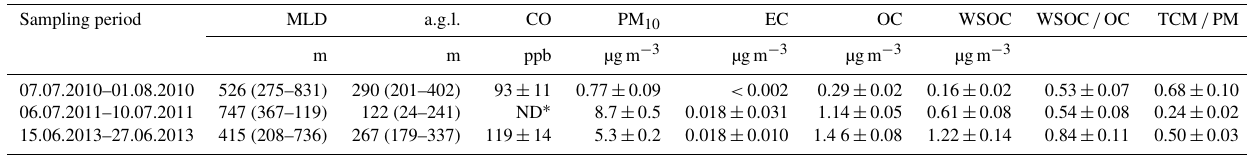
Table 5. Average CO, PM 10 , and carbonaceous species concentrations ( ± SD) together with WSOC / OC and TCM / PM ratios obtained during the cleanest periods in the growing season. MLD and ma.g.l. are median and 25–75th quartiles of the mixed layer depth and air mass trajectory height above ground level, respectively.